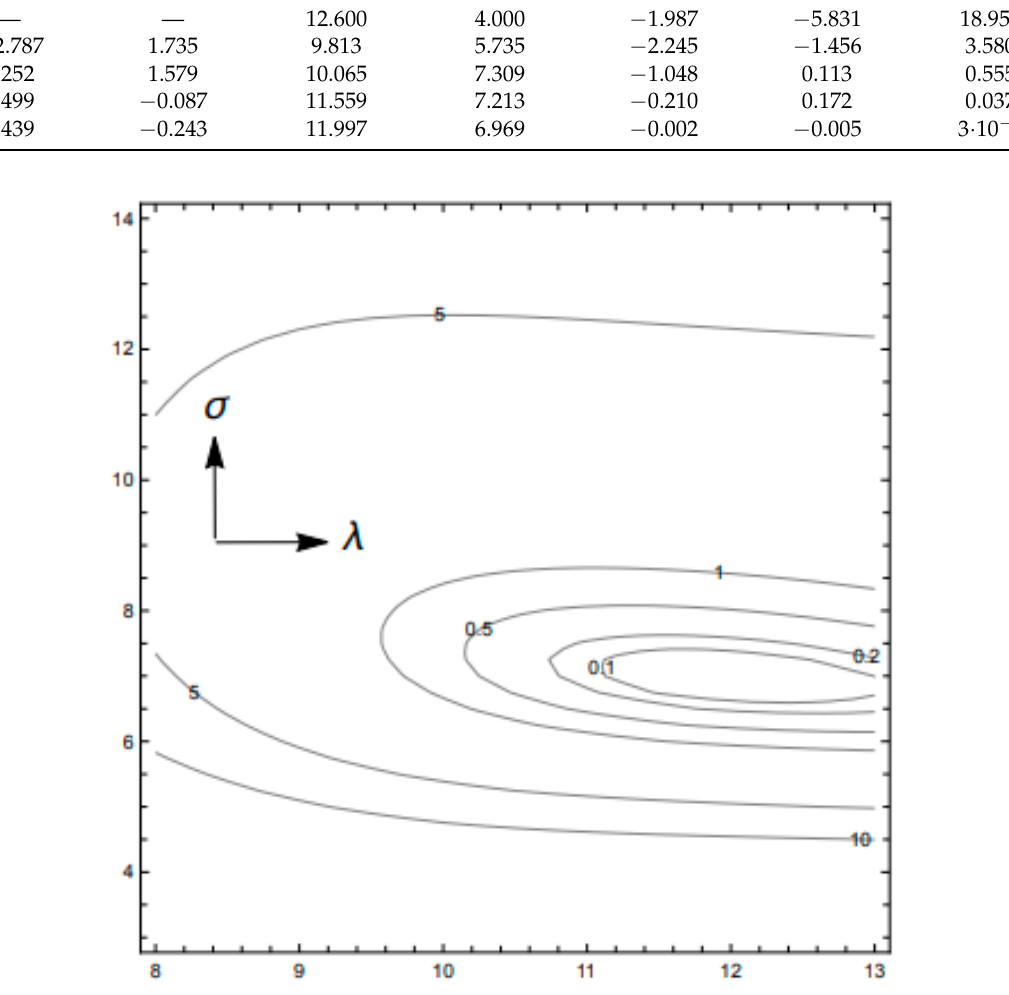
Figure 10. Plot of the cost function given by Equation (32). The minimum is located at λ = 12.0, σ = 7.0 ( λ the horizontal axis and σ the vertical axis).